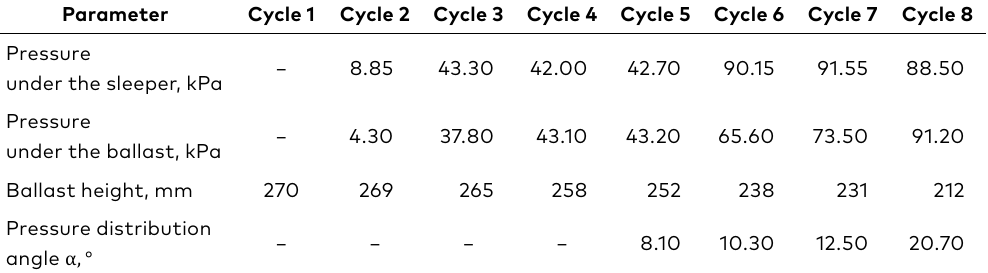
Table 1. The comparison of pressure distribution under the sleeper and the ballast for central sensor No.